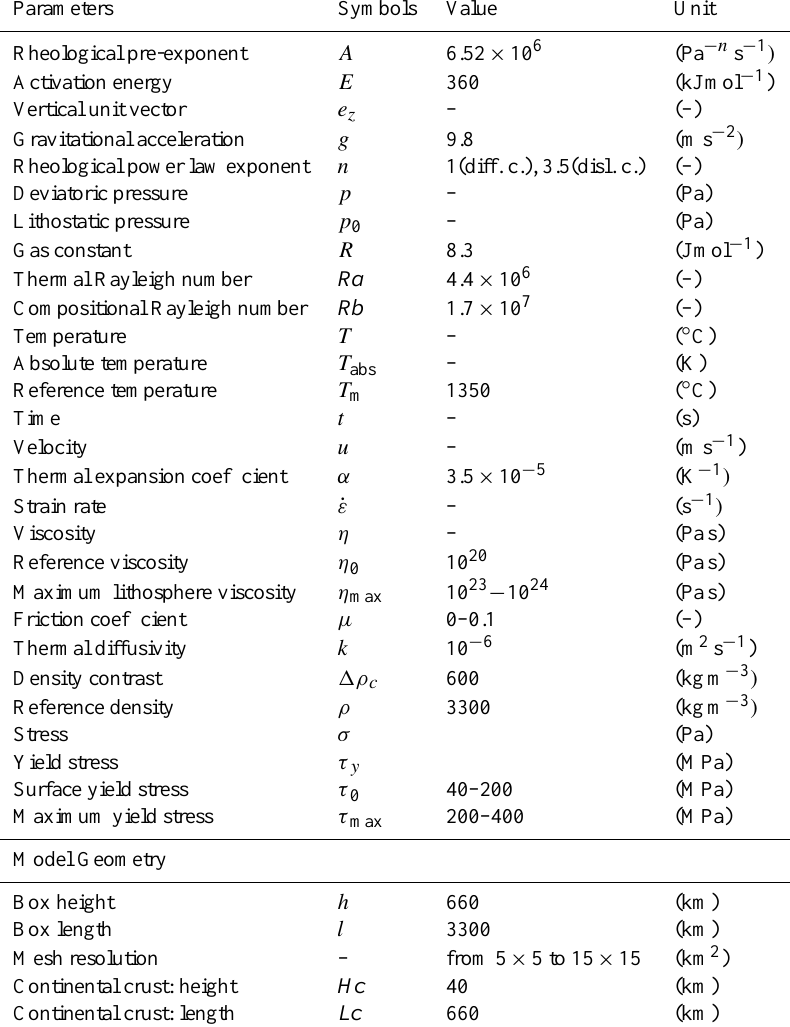
Table 1. Symbols, units and default model